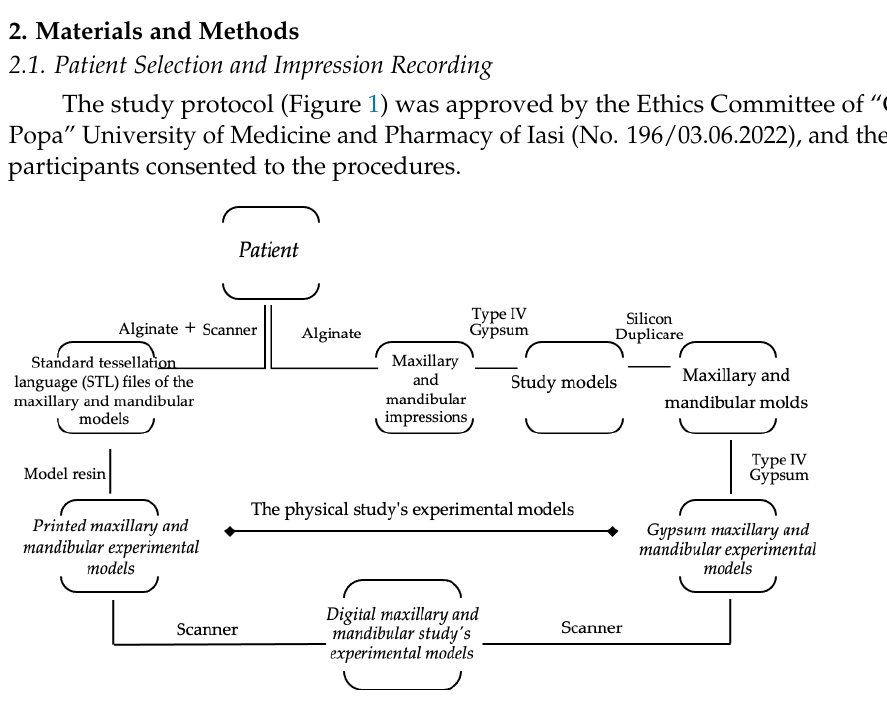
Figure 1. The study protocol’s design: from patient to digital case study models. To perform the experimental models, alginate maxillary and mandibular impressions were taken from patients.